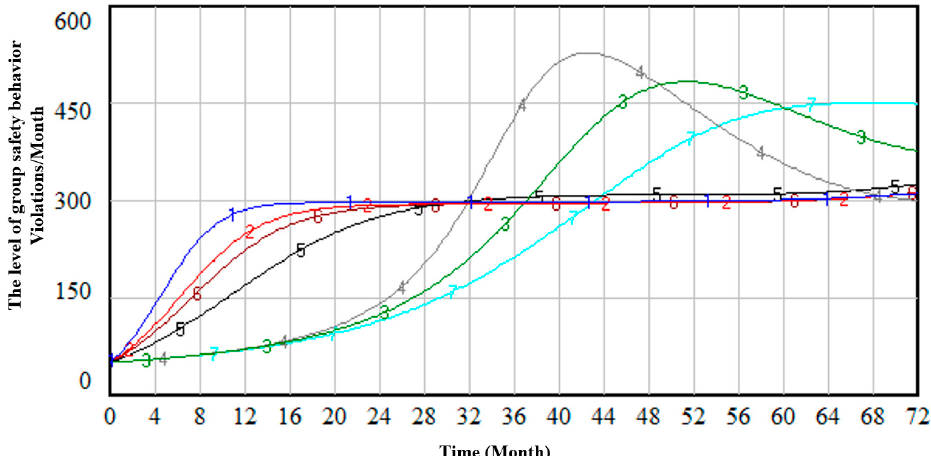
Figure 6. Simulation of organizational management intervention decision. Line 1 shows the impact of safety education and training on the level of group safety behavior, Line 2 shows the impact of improving leadership on the level of group safety behavior, Line 3 shows the impact of safety pro- tection facilities on the level of group safety behavior, Line 4 shows the impact of safety occupational adaptability evaluation on the level of group safety behavior, Line 5 shows the impact of safety supervision on the level of group safety behavior, Line 6 shows on the impact of safety production system on the level of group safety behavior, Line 7 shows the initial data.